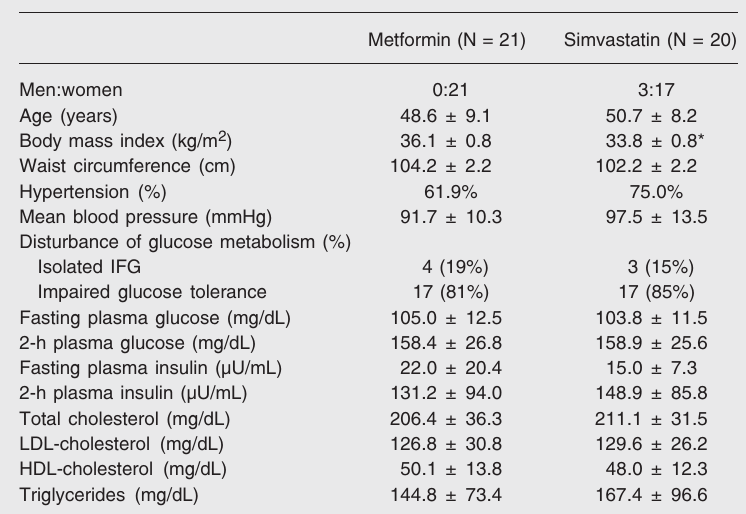
Table 1. Baseline characteristics of patients treated with metformin or simvastatin for 16 weeks.